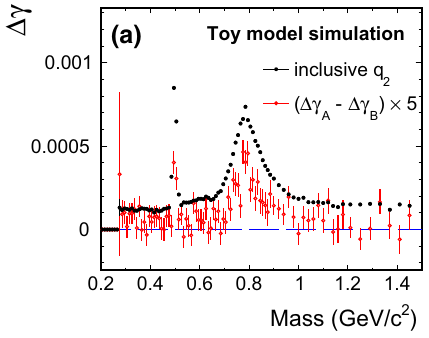
and (cid:2)γ B are calculated in two event classes selected by q 2 , correspond- ing to the 50% high- q 2 and 50% low- q 2 events, respectively. Each data √ = 200 GeV. (cid:2)γ s point in panel ( b ) corresponds to one m inv bin in panel ( a ) A NN